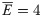
Complex behaviour of orbits generated by (4).Top panels correspond to z = 210, r = 1, and bottom panels show dynamics of (4) for z = 135, r = 1.5. Other parameters of the model are: w = 1.5, p = 0.1, E¯=4, E_=2, ε = 0.05. Green curves show (8), solid red line shows E*=E¯−rq*/ε, and dashed orange line corresponds to E* = rq*. Intersection of the solid green and red curves above the dashed curve reveals equilibrium (6). Left panels present the evolution of qt and Et as functions of t. Right panels show the values of pairs (qt, Et) for t ∈ [2.8 ⋅ 105, 3 ⋅ 105].